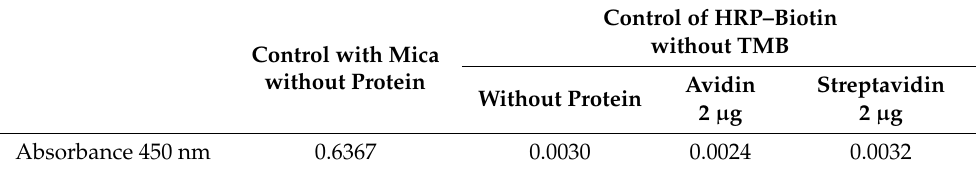
Table 1. Mean values of the ultraviolet–visible spectroscopy measurements of the negative controls assayed at a wavelength of 450 nm. Mica pieces of 1.0 cm 2 for all the experiments were used. Error is below 5%. Control of HRP–Biotin without TMB Control with Mica without Protein Without